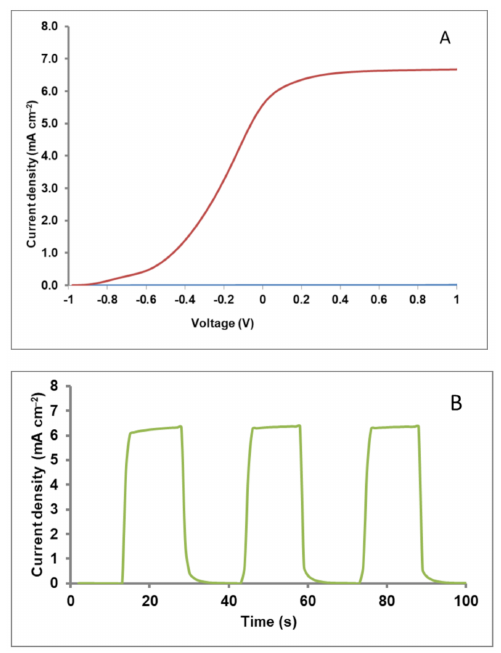
Figure 11. ( A ) Linear sweep voltametry with the presently used photocatalytic fuel recorded in a two- electrode configuration (no reference electrode) without a supercapacitor electrode. ( B ) Potentiostatic variation of the current density at V = 0 V by periodic light chopping. The electrolyte was 0.5 M aqueous NaOH containing 5% v/v